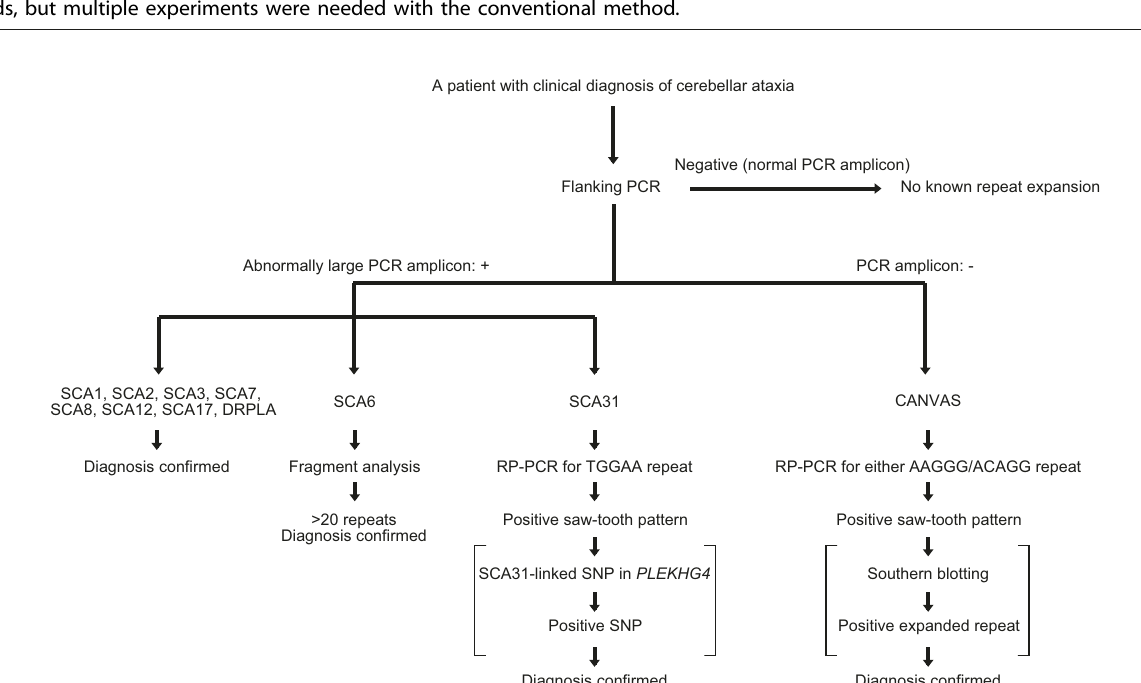
Fig. 4 Examples of four samples for three loci in the discovery study. For a – c , the conventional study results are shown on the left and the results of our diagnostic method using GridION are shown on the right. Posi positive control, Nega negative control, NTC no template control, RP-PCR repeat-primed PCR. a Upper left panel shows the fl anking PCR result for the CACNA1A locus. Patient 13 and six other patients (1 – 6) were tested using a 2% agarose gel and only the patient labeled “ 2 ” was judged as positive. Upper right panel shows T-LRS results detecting CACNA1A as the rank #1 locus. Lower right panel shows the con fi rmatory fl anking PCR and fragment analysis of the CACNA1A locus. Flanking PCR was evaluated on a 2.5% agarose gel. b Left panel shows fl anking PCRs result for the ATXN8OS/ATXN8 locus. Right panel shows the T-LRS result detecting ATXN8OS/ATXN8 as the rank #1 locus but with ambiguous pathogenicity. The rank #2 locus was also rejected for pathogenicity. c Left panel shows an abnormally expanded PCR amplicon in BEAN1 , RP-PCR detecting a pathogenic TGGAA repeat, and Sanger sequencing for an SCA31-linked SNP in which one of the patients (Patient 14) did not have this SNP. Right panel shows the T-LRS result detecting the rank #1 locus as BEAN1 and SCA31-linked SNP genotyping shown in the integrative genomics viewer. The result was matched between the two methods, but multiple experiments were needed with the conventional method.